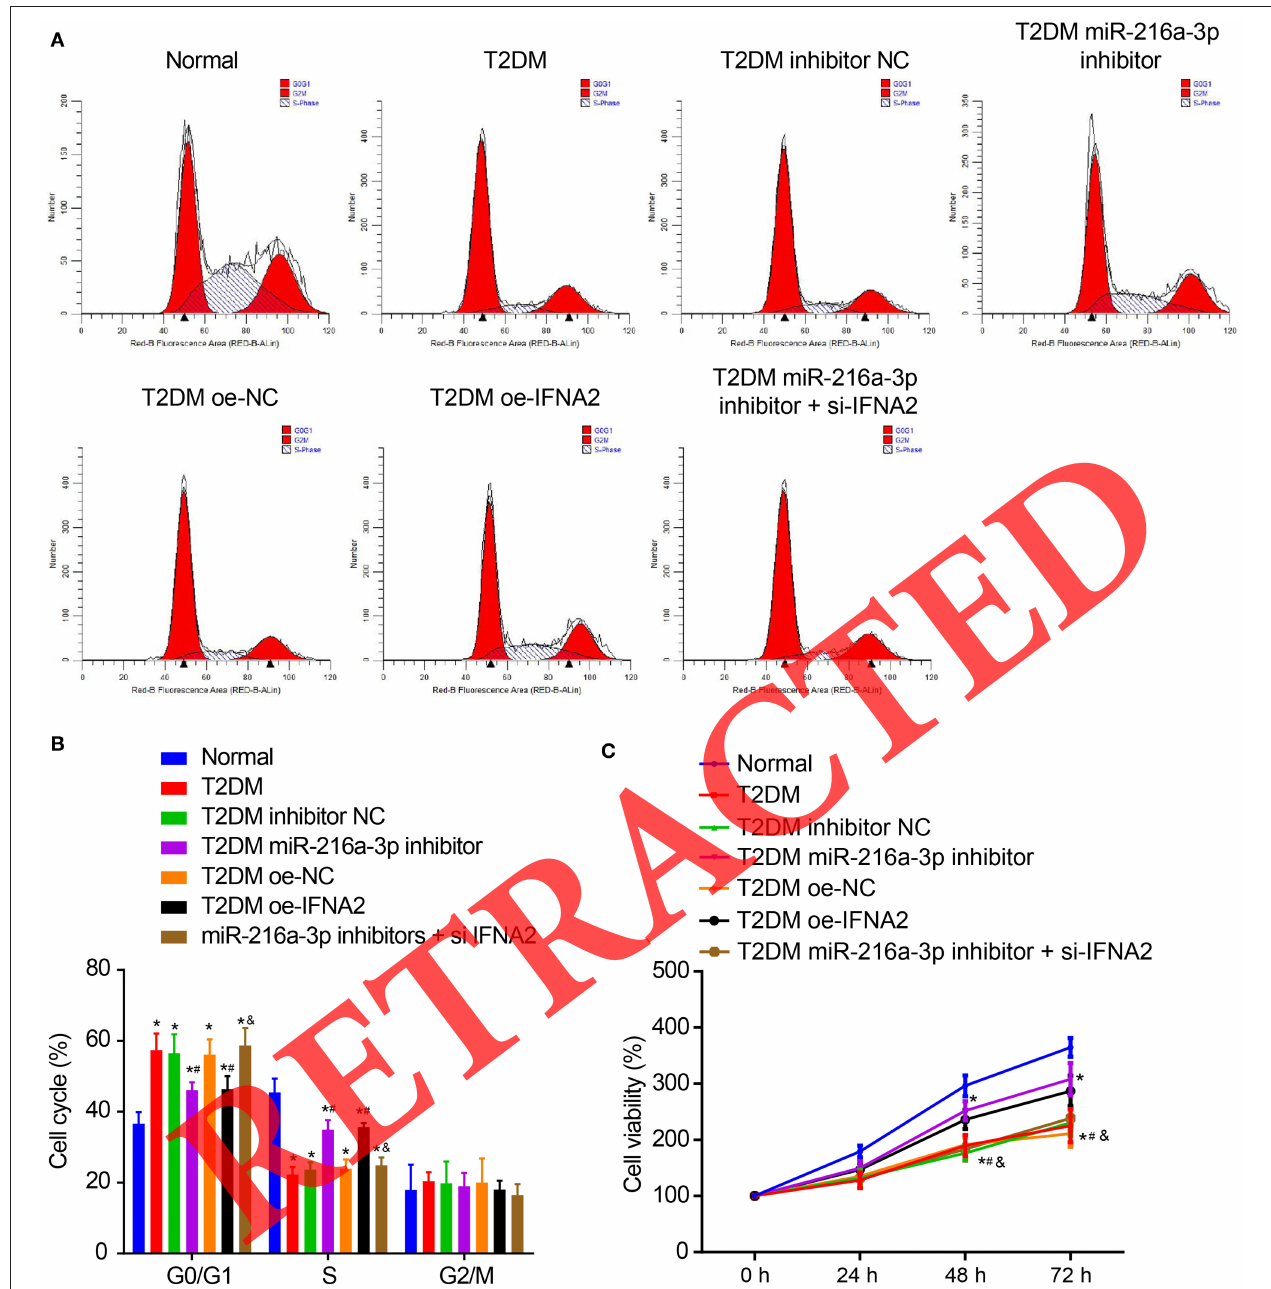
FIGURE 5 | miR-216a-3p downregulated IFN- α 2 to suppress T2DM cardiomyocyte proliferation. (A,B) Myocardial cell cycle in each group by flow cytometry; (C) MTT used to detect the cell viability of myocardial cells in each group. * p < 0.05 vs. the normal group; # p < 0.05 vs. the T2DM/T2DM inhibitor NC/T2DM oe-NC group; & p < 0.05 vs. the T2DM miR-216a-3p inhibitor group. The data were measurement data and presented by the mean ± standard deviation and analyzed by repeated-measures ANOVA. The experiment was repeated three times. OD, optical density; siRNA, small interference RNA.